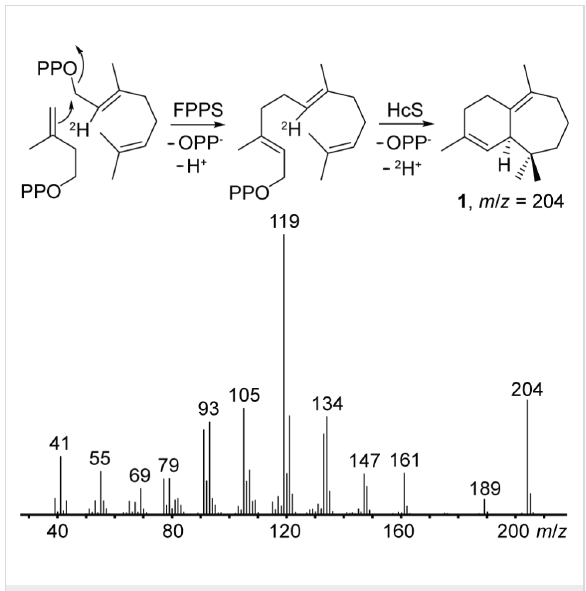
Figure 3: EI mass spectrum of 1 arising from an incubation of (2- 2 H)GPP and IPP with FPPS and HcS showing a loss of label during